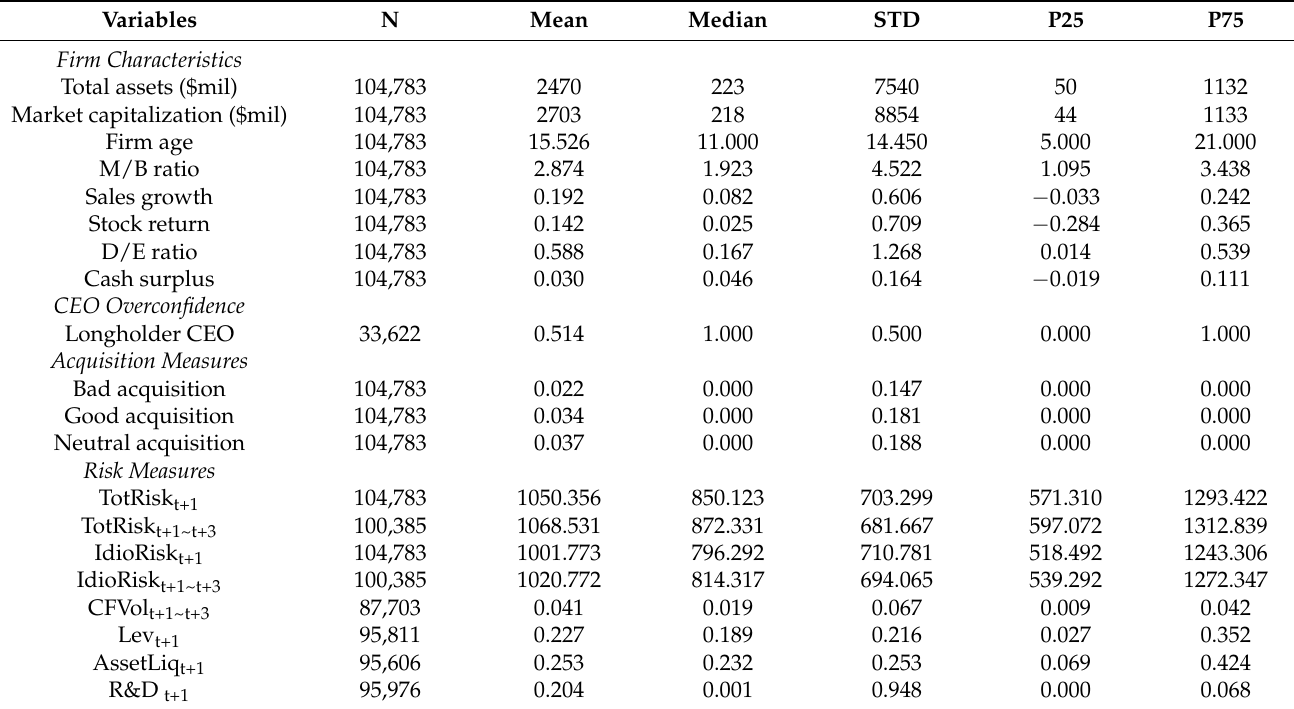
Table 2. Summary statistics. This table presents the full sample summary statistics of 104,783 firm-year observations between 1990 and 2015. Variable definitions are in Appendix